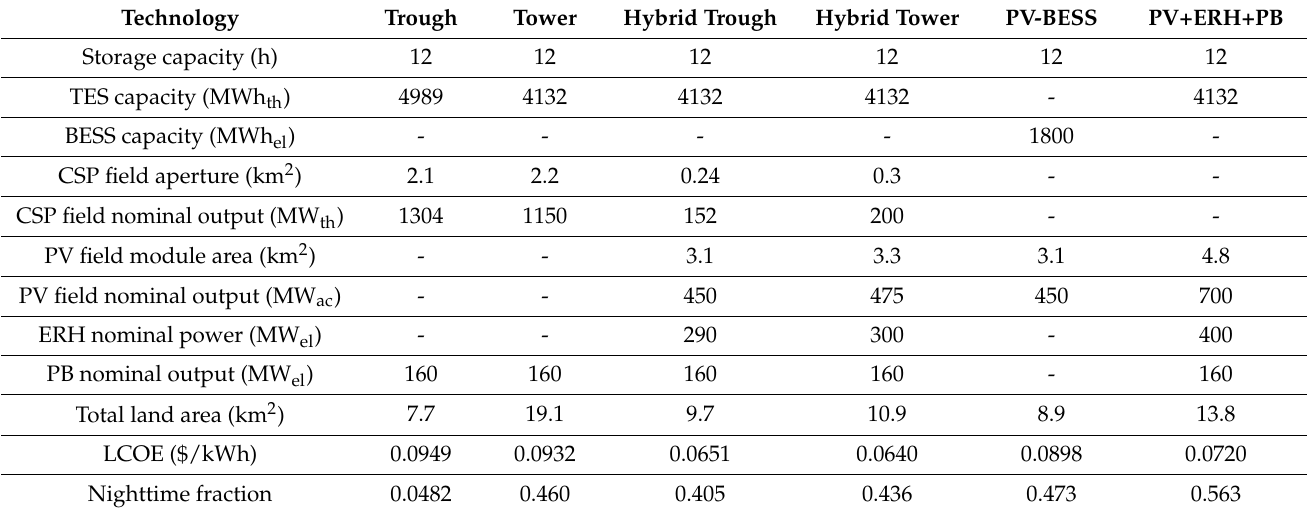
Table 6. Parameters of the twelve-hour optimized